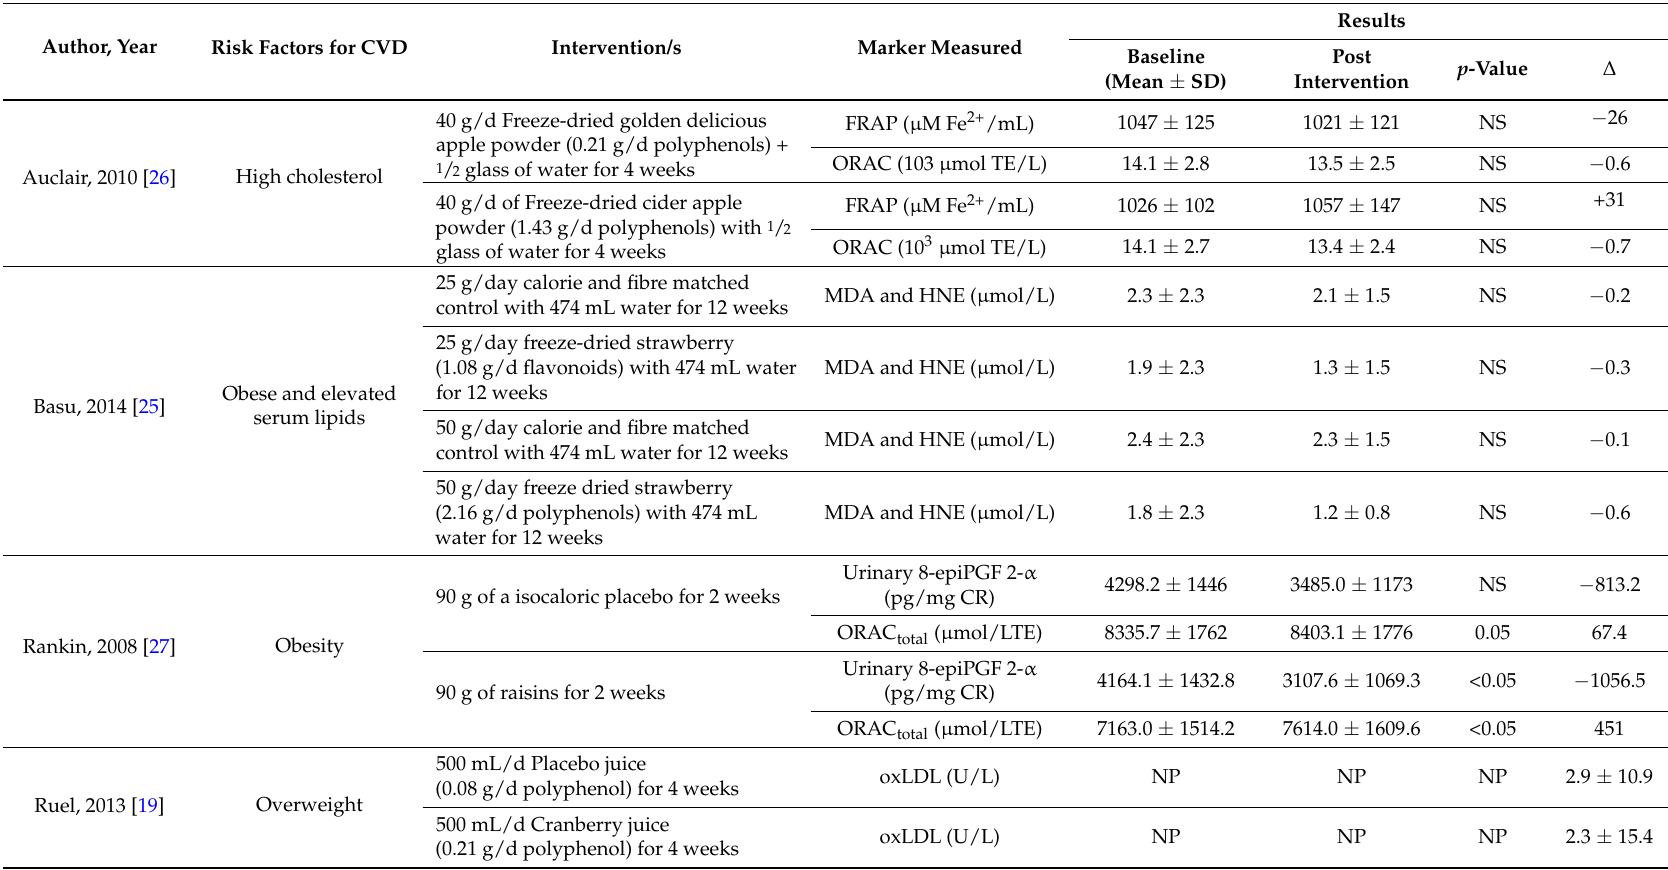
Table 5. Effect of fruit polyphenols oxidative stress at baseline and